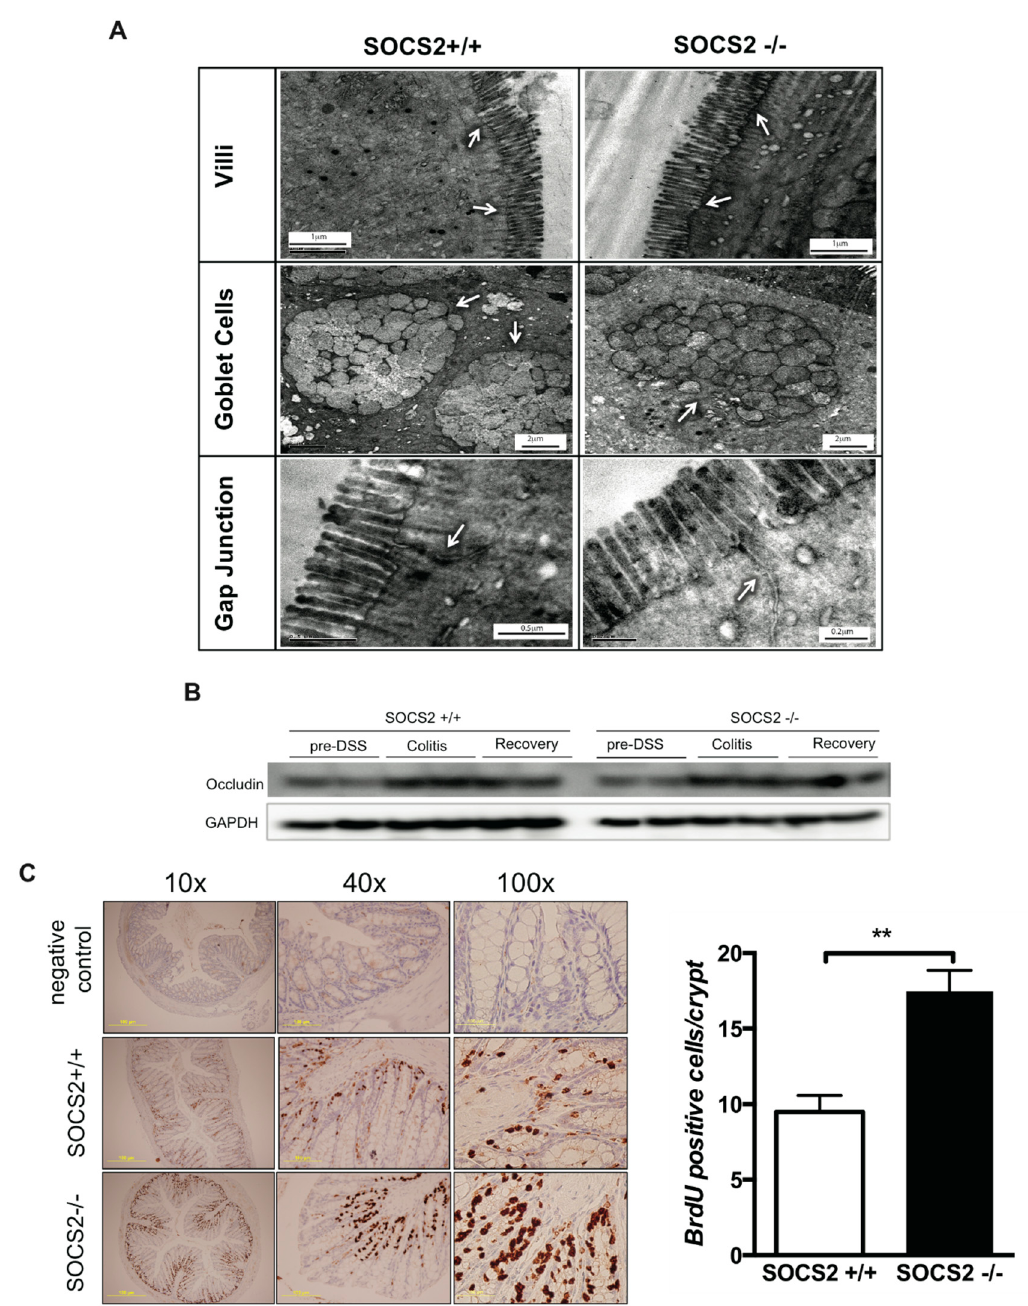
Figure 4. Colonic microscopic changes and epithelial regeneration. ( A ) Transmission electron microscope images of colons of both mice not treated by dextran sodium sulphate (DSS). The ultra-structure of the villi, goblet cells and gap junctions (white arrows) are shown. ( B ) Western blot of the gap junction protein occludin. ( C ) In vivo colonic epithelial proliferation measured by immunohistochemical staining of BrdU in colonic tissues of mice without treatment with DSS. Colonic tissues were fixed 4 h post intraperitoneal injection of BrdU. Sections are shown in 10 × and 40 × magnification. Negative control tissues are from mice not injected with BrdU. Total positive cells per crypts are shown in the bar diagram. A total of 20–23 crypts were studied per mouse sample and 5 mice per group were studied. Student’s t -test p -value ** <0.01.